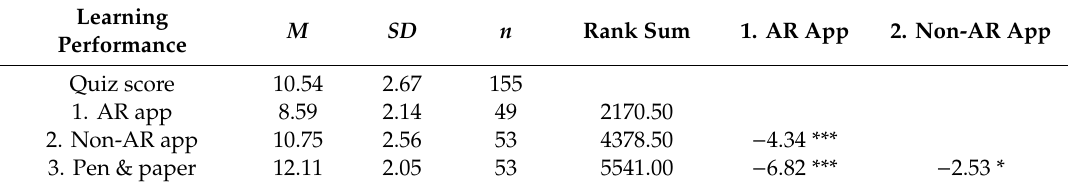
Table 5. Means ( M ), Standard Deviations ( SD ), Frequencies ( n ), Rank Sum, and Dunn’s Multiple Nonparametric Pairwise Post Hoc Test with Bonferroni Corrections for Di ff erences in Dependent Variable of Learning Performance ( N =